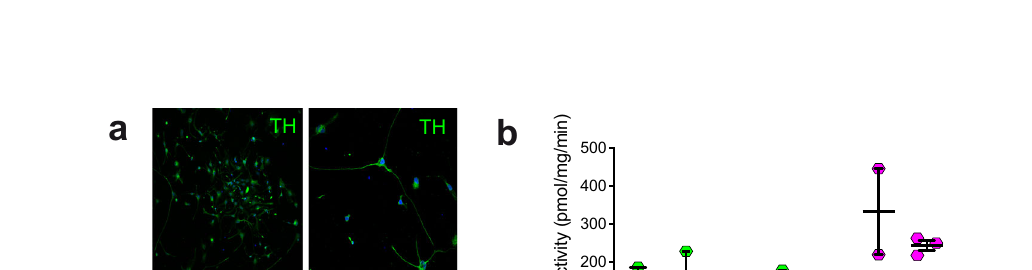
Fig. 3 Ultrastructural analysis of endo-lysosomal compartment and GCase function in fi broblasts from LRRK2 G2019S mutant compared with controls. a Low magni fi cation (2 – 5 µm) TEM micrographs showing electron-dense structures accumulating in the LRRK2 G2019S fi broblasts (Patient #1), while they are almost completely absent in control cells (Control #1). b High magni fi cation (500 nm) TEM images three patient fi broblast cell lines and age and sex matched controls. Patient fi broblasts show accumulation of endo-lysosomal structures that resemble multilamellar bodies (MLBs). c Violin plots of the number of the MLBs per µm 2 for each patient and each control cell line, showing that the number of MLBs is larger in LRRK2 G2019S fi broblasts than in control cells (given a certain degree of variability across individuals) (one-way ANOVA, Tukey ’ s multiple comparisons test; ** p < 0.01, *** p < 0.001, **** p < 0.0001). d Western blot analysis of GCase, LIMP2, pT731 RAB10 and total RAB10. e Quanti fi cation of ELISA assays for pS935 LRRK2, total LRRK2 (UDD3 antibody) and pLRRKtide (ng/ml LRRK2) (Mann – Whitney non-parametric test, p > 0.05; data are expressed as mean ± SEM). f Quanti fi cation of western blots in e (Mann-Whitney non- parametric test, controls vs. patients: pRAB10 p > 0.999, GCase p = 0.0095, LIMP2 p = 0.019; data are expressed as mean ± SEM). g CGase activity assessed with the in-lysate 4-MU method. G2019s patients display increased activity compared to controls while MLi-2 treatment has no effect in both genotypes (two-way ANOVA, genotype effect p = 0.001 F (1, 16) = 16.04, treatment effect p = 0.2891 F (1, 16) = 1.202). h GCase activity assessed with the in-cell method from Benz 2021 protocol is signi fi cantly increased in G2019S patients (Mann – Whitney non- parametric test, p = 0.0381; data are expressed as mean ± SEM). Each dot represents one subject and the value is the average of two biological replicates each with three technical replicates.